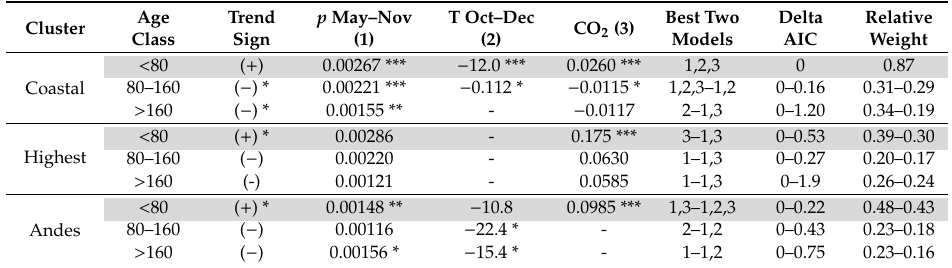
Table 2. Linear mixed-e ff ect models represent the influence of climatic variables (precipitation, temperature and CO 2 ) on basal area increment (BAI) for the periods 1980–2014, according to the cluster population and age classes. Grey cells show significant negative e ff ects of CO 2 on BAI (* p < 0.10, ** p < 0.05, *** p <